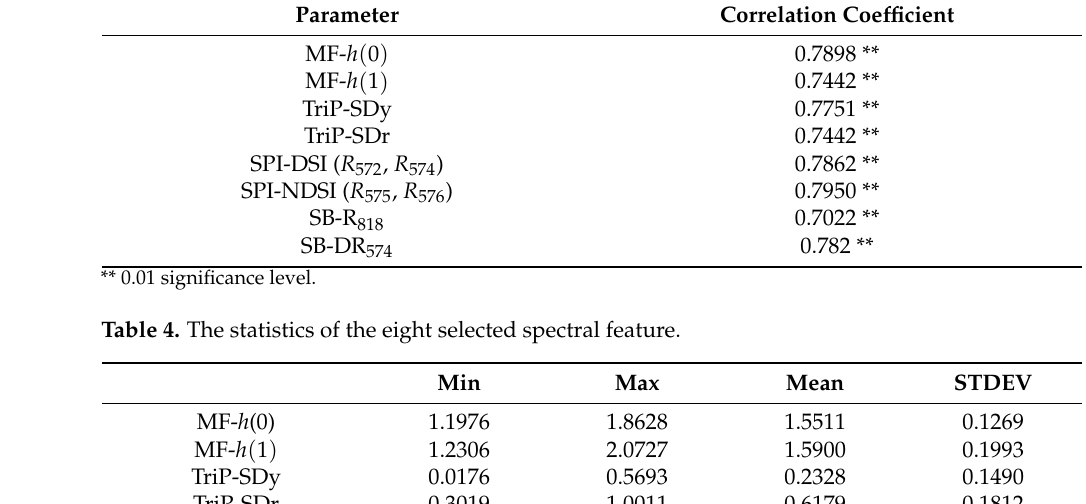
Table 3. The first two parameters with the best correlation in each hyperspectral feature. Parameter